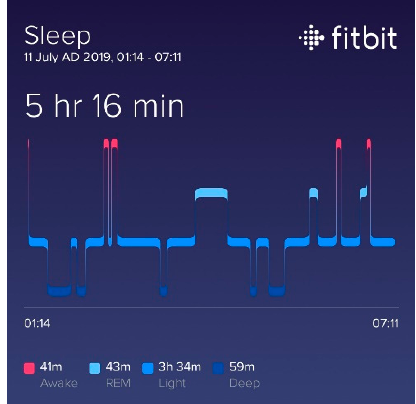
Figure A12. Bangkok,